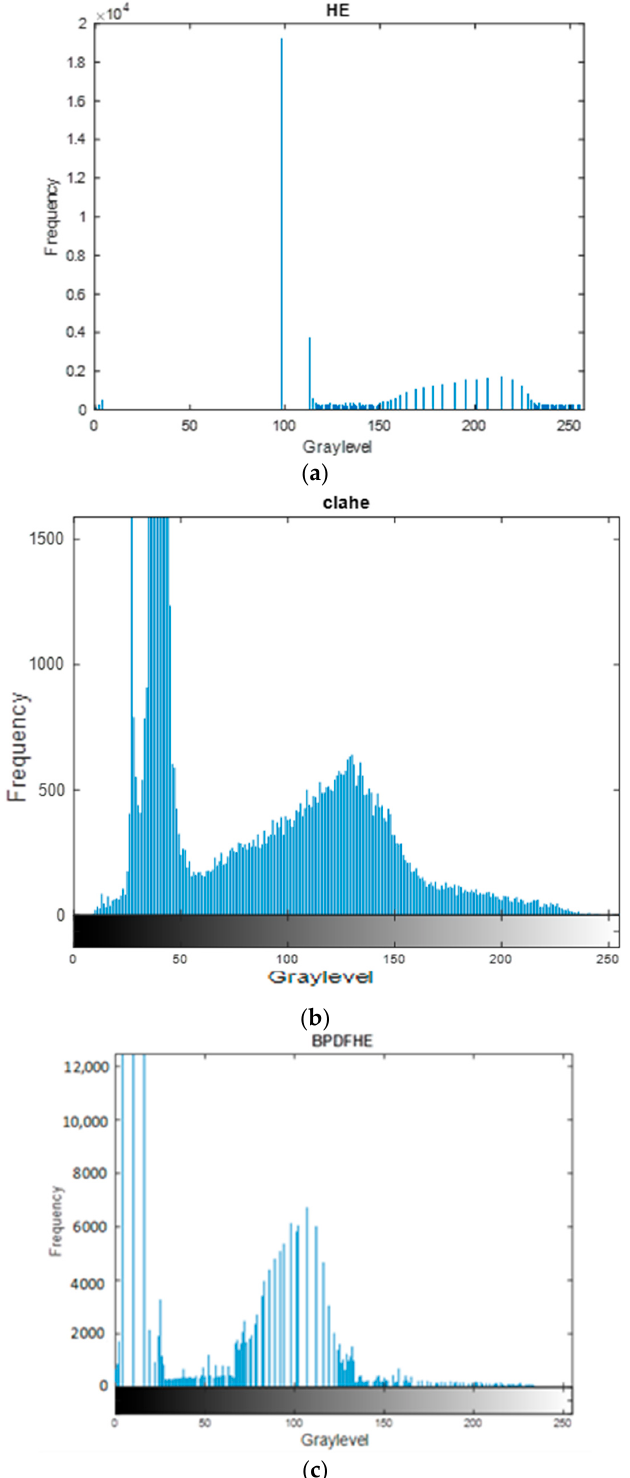
Figure 6. Histograms of preprocessed images of Figure 5. ( a ) HE, ( b ) CLAHE, and ( c ) BPDFHE. Figure 7a is the original image. Figure 7b is its histogram representation. Figure 8a–c represents the same image enhanced via different preprocessing methods, i.e., HE, CLAHE, BPDFHE, and Figure 9a–c is their respective histograms .